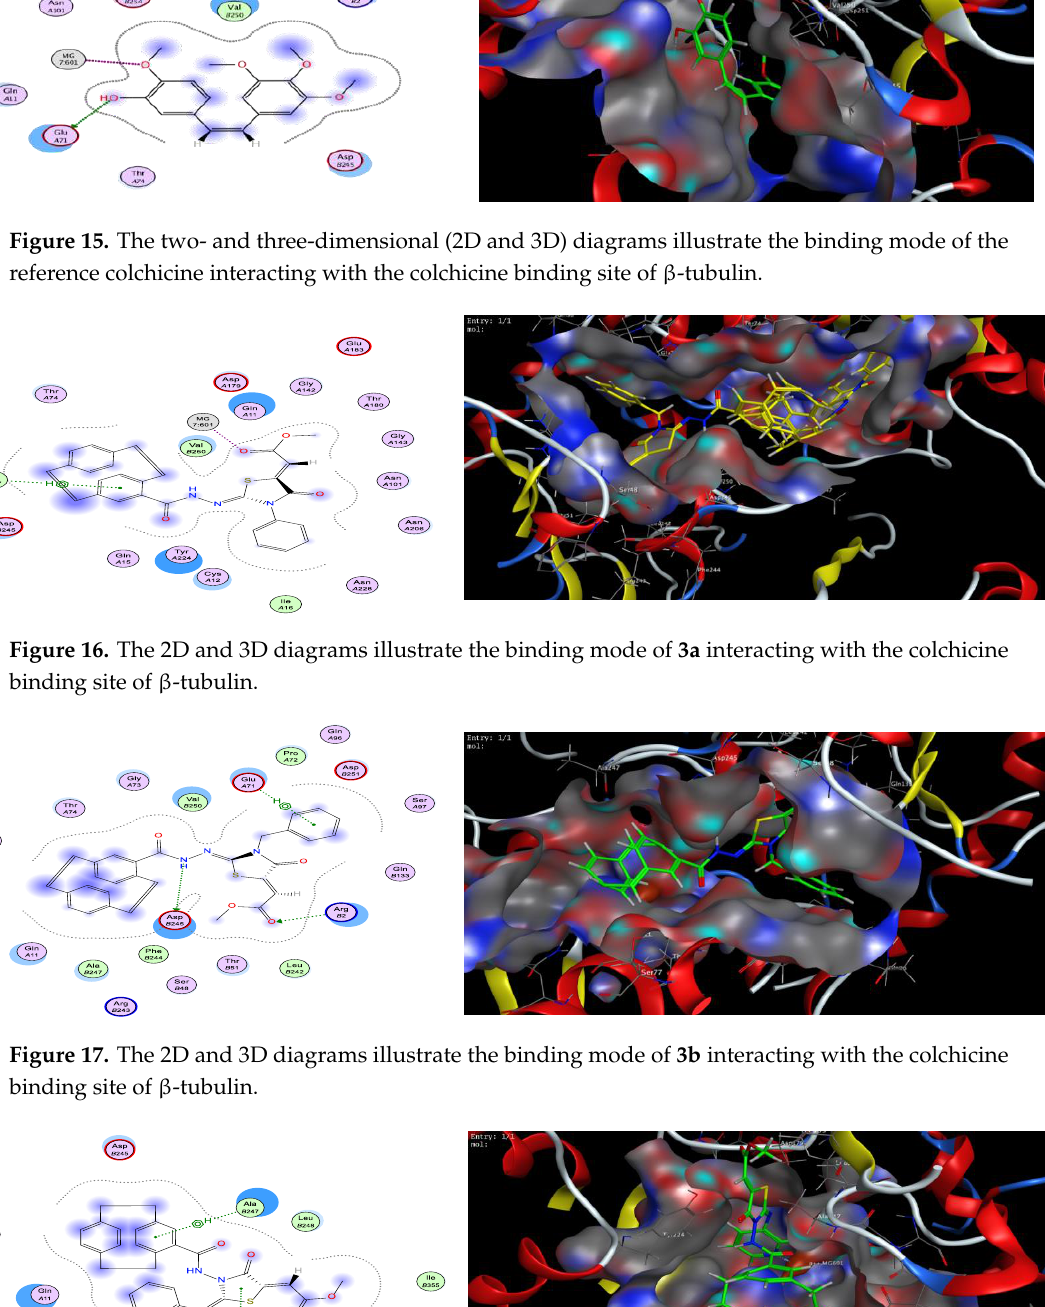
Figure 19. The 2D and 3D diagrams illustrate the binding mode of 3d interacting with the colchicine binding site of β-tubulin.